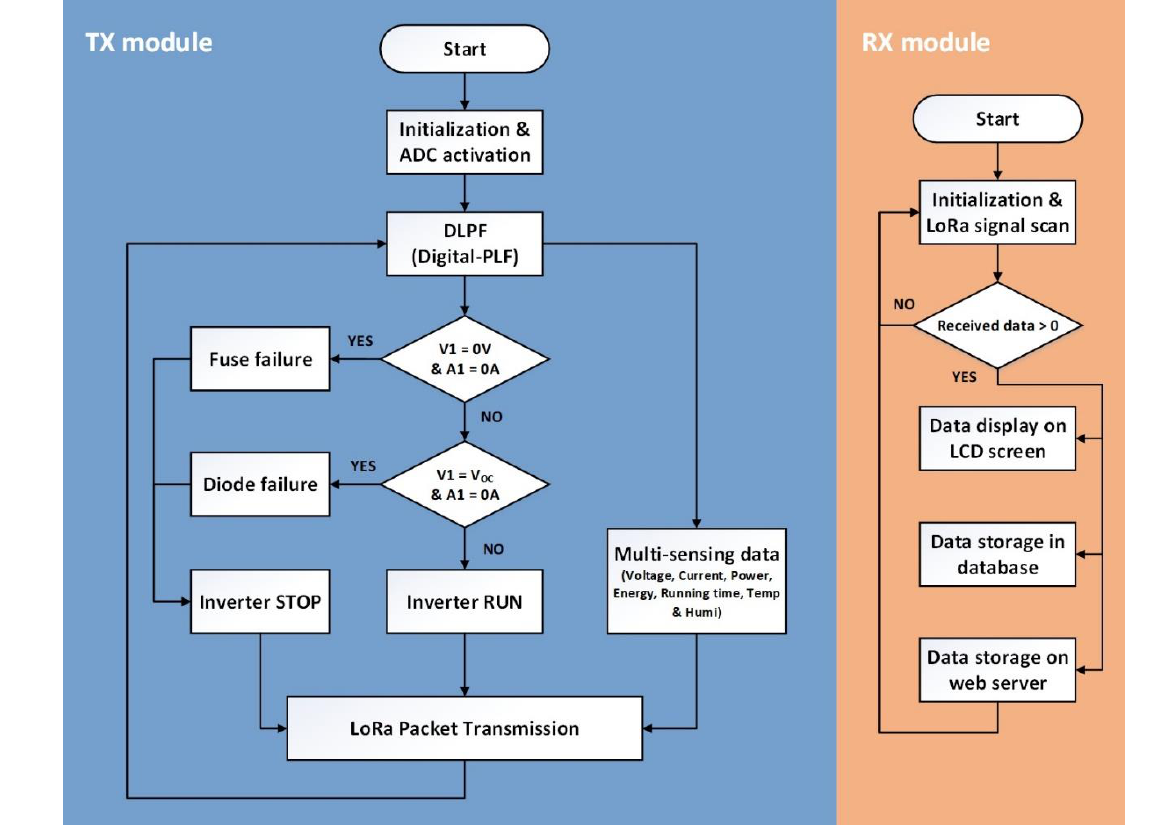
Figure 4. A flow chart of the proposed operation algorithm in PV junction box monitoring system.